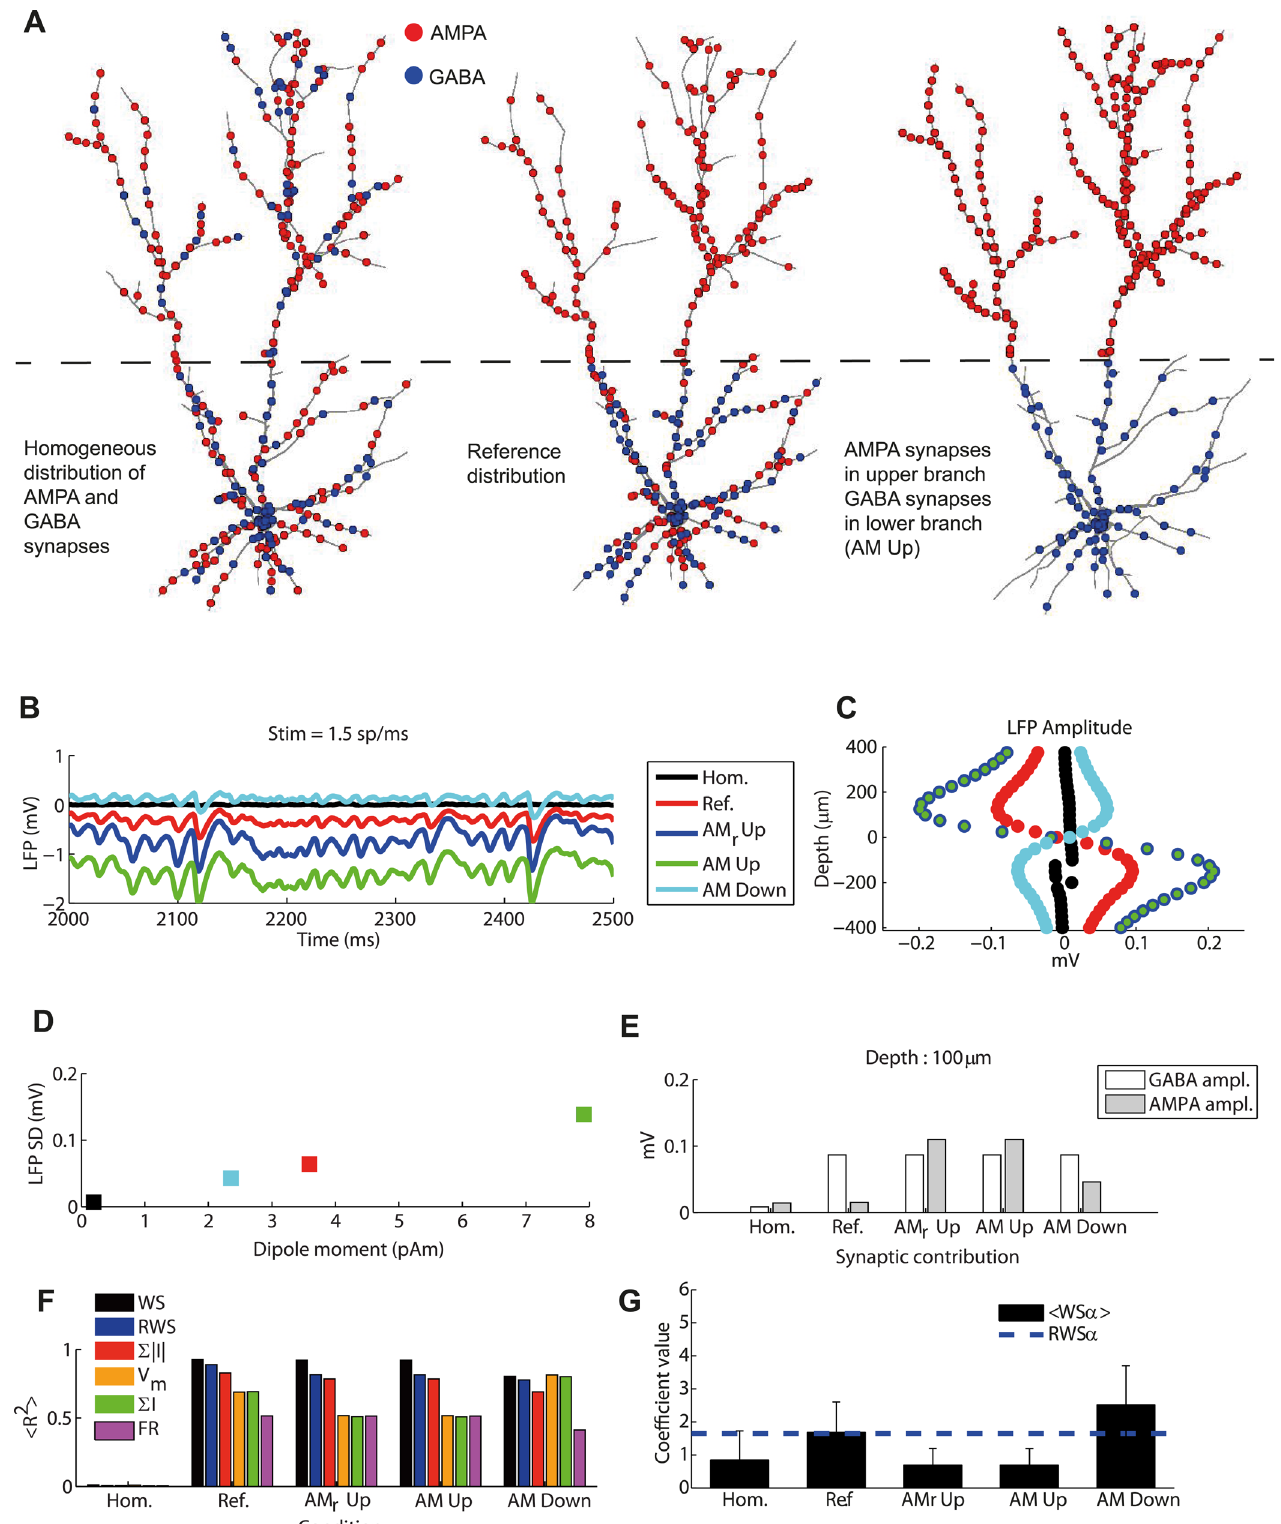
Fig 9. LFP signal and synaptic distribution. (A) Example cases for different synaptic distributions. Left: both AMPA and GABA synapse distributed over the entire surface of the cell. Center: GABA synapses distributed only in the lower cylinder, with AMPA synapses distributed over the entire cell. Right: